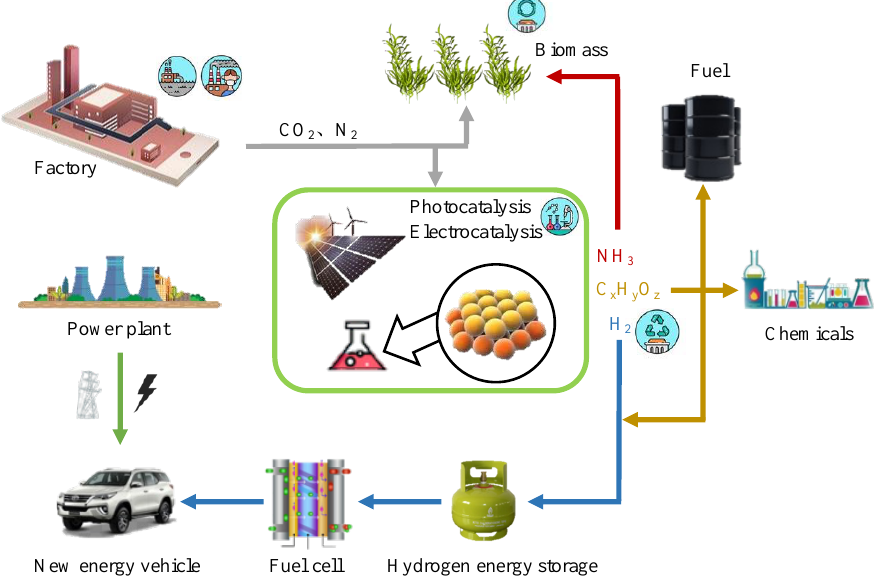
Figure 1. Illustration of future sustainable energy development.